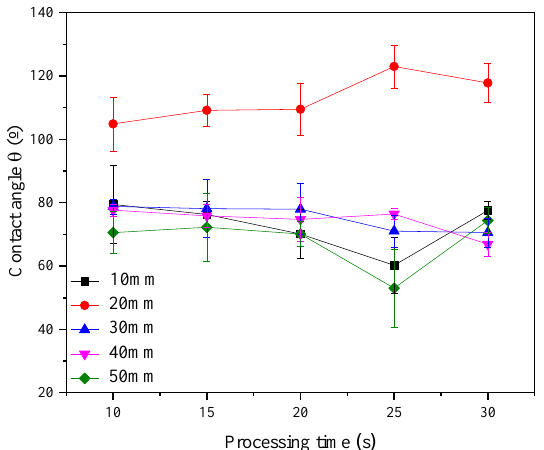
Figure 10. Comparison of measured mean values and standard deviations of contact angle for different electrode distances and processing times, when KNO 3 concentration of 5 wt.% and AgNO 3 concentration of 0.03 wt.% are fixed.